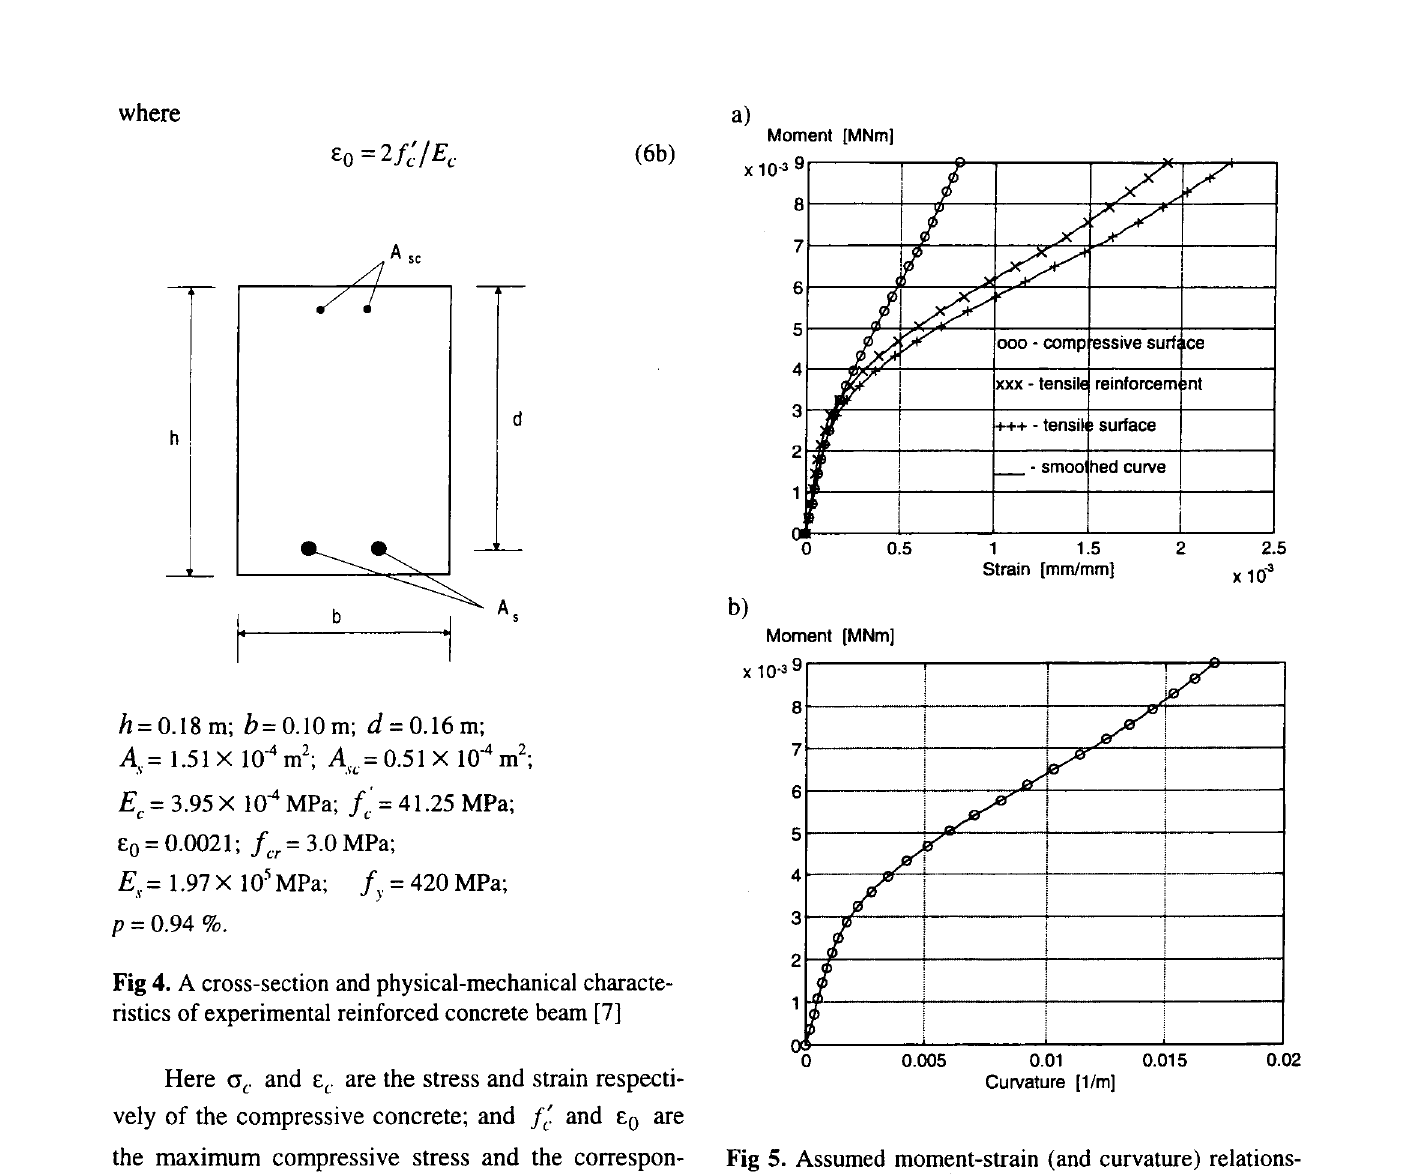
Fig 4. A cross-section and physical-mechanical characte ristics of experimental reinforced concrete beam [7] Here crc and Ec are the stress and strain respecti J;. vely of the compressive concrete; and and Eo are the maximum compressive stress and the correspon Fig 5. Assumed moment-strain (and curvature) relations hips in the numerical test (a) - moment-strain curves ding strain for standard cylinder test. Though both va (b)- moment-curvature lues in computations are taken as negative, in the text the sign minus is omitted.